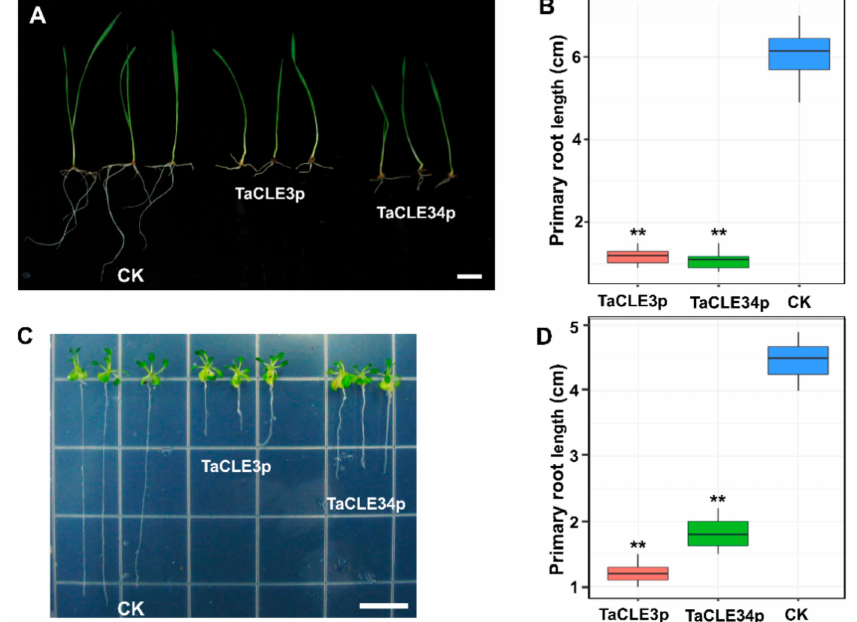
Figure 4. The e ff ect of TaCLE3p and TaCLE34p on wheat and Arabidopsis root growth. ( A , C ) Representative pictures are shown for wheat ( A ) at 8 d after germination and Arabidopsis ( C ) at 12 d after germination. ( B , D ) Quantification of the primary root length of wheat seedling ( n = 10) ( B ), and Arabidopsis seedling ( n = 12) ( D ). The bar graphs indicate the mean ± SE. Statistical significance (Student’s t -test) compared with no peptide treatment (CK) is indicated: ** p < 0.01. Scale bars: 1 cm in ( A , C ).